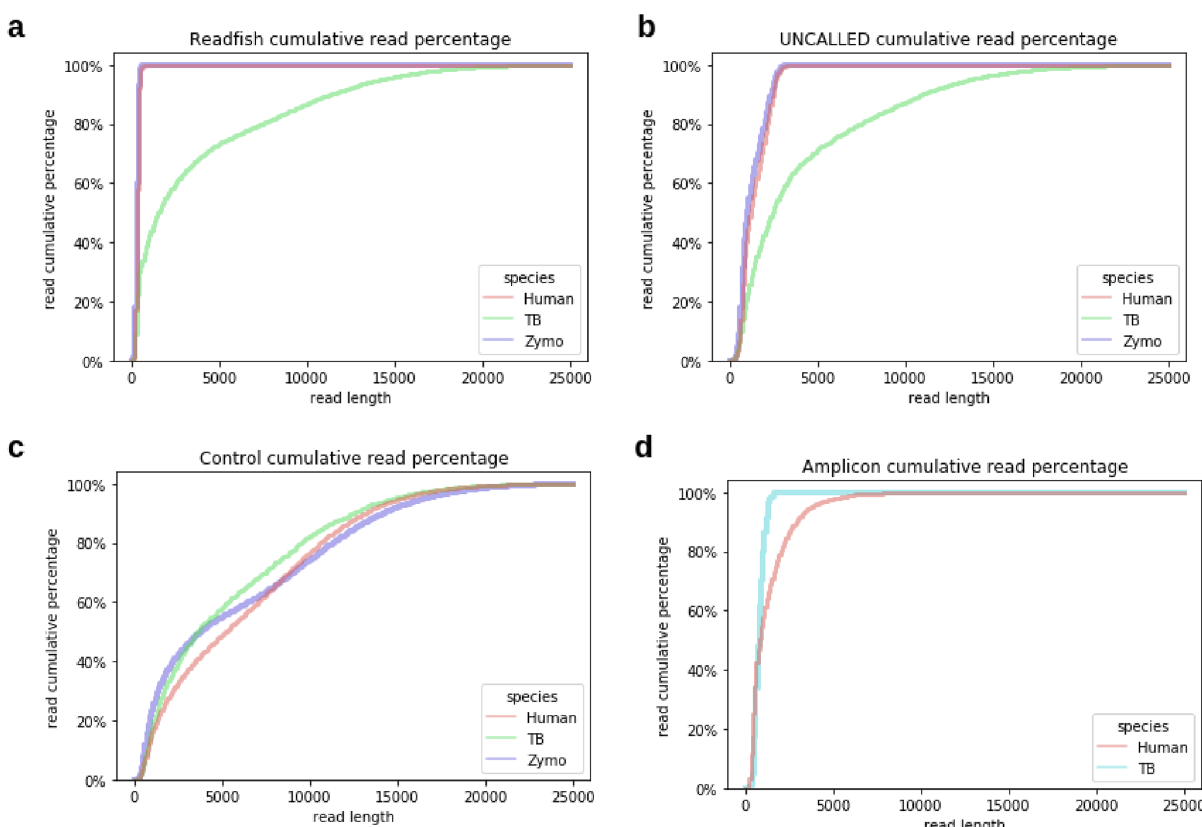
Figure 2. Read length distributions among different samples. The read cumulative percentage over different read lengths (bp) from different species at samples generated via adaptive sequencing of ( a ) a readfish run, ( b ) UNCALLED run, ( c ) Control run, and ( d ) Amplicon run. Compared with the control run, in which different species reads had similar read length distribution, the readfish and UNCALLED runs had a distinct pattern; the target species, TB, had a much longer read length, while the non-target reads, human and Zymo, had a limited read length (99% of human and Zymo reads < 500 bp in readfish and < 2900 bp in